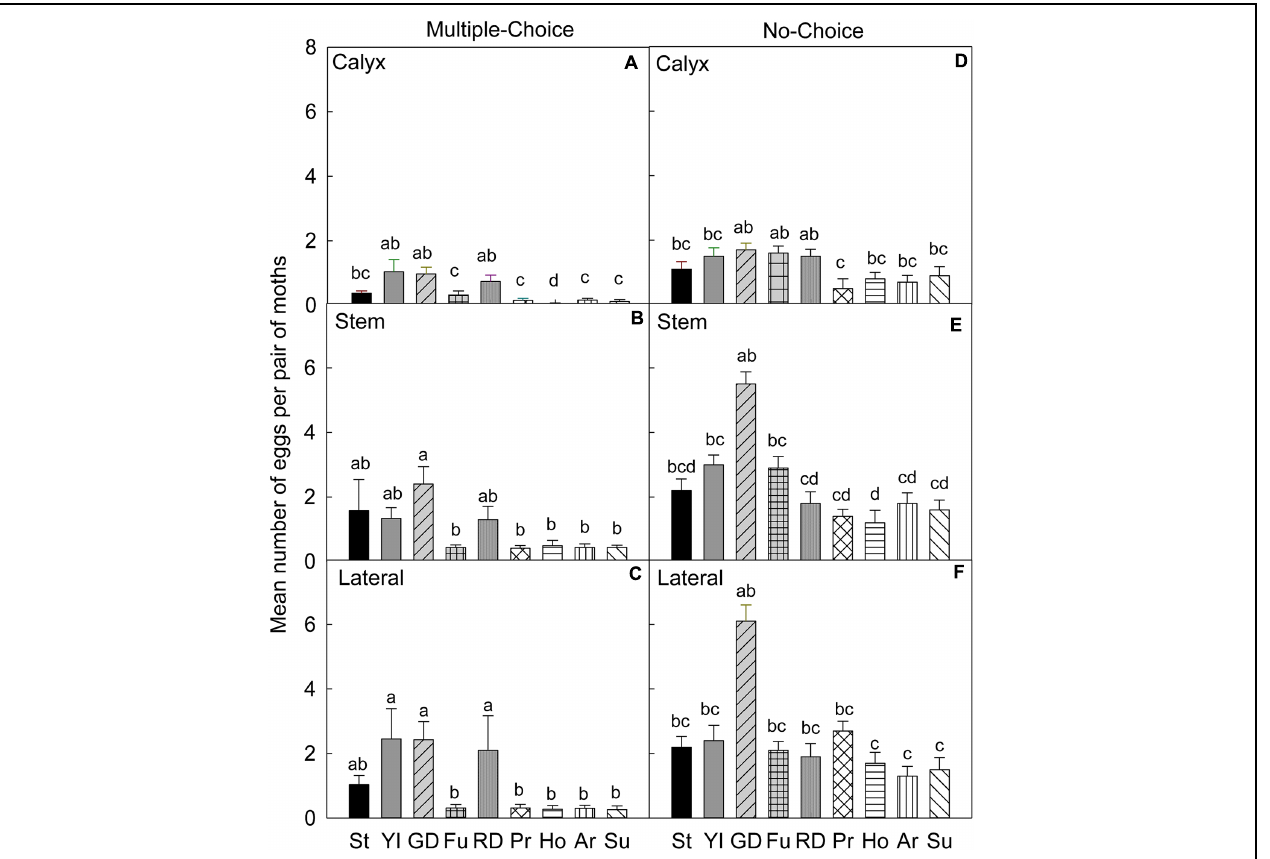
FIGURE 1 | Relative susceptibility of different apple cultivars for oviposition of codling moth during July 2006 (early season/Set 1). Mean number of eggs per pair of moths per fruit on calyx, stem, and lateral sides of fruits of different cultivars are shown in multiple-choice tests (A–C) and no-choice tests (D–F) . St, Stayman; YI, York Imperial; GD, Golden Delicious; Fu, Fuji; RD, Delicious; Pr, Pristine; Ho, Honeycrisp; Ar, Arlet; Su, Sunrise. N = 8 for all the multiple-choice tests, and N = 10 for all the no-choice tests. Each bar represents standard error of mean. Different letters over bars indicate significant difference ( P < 0.05).